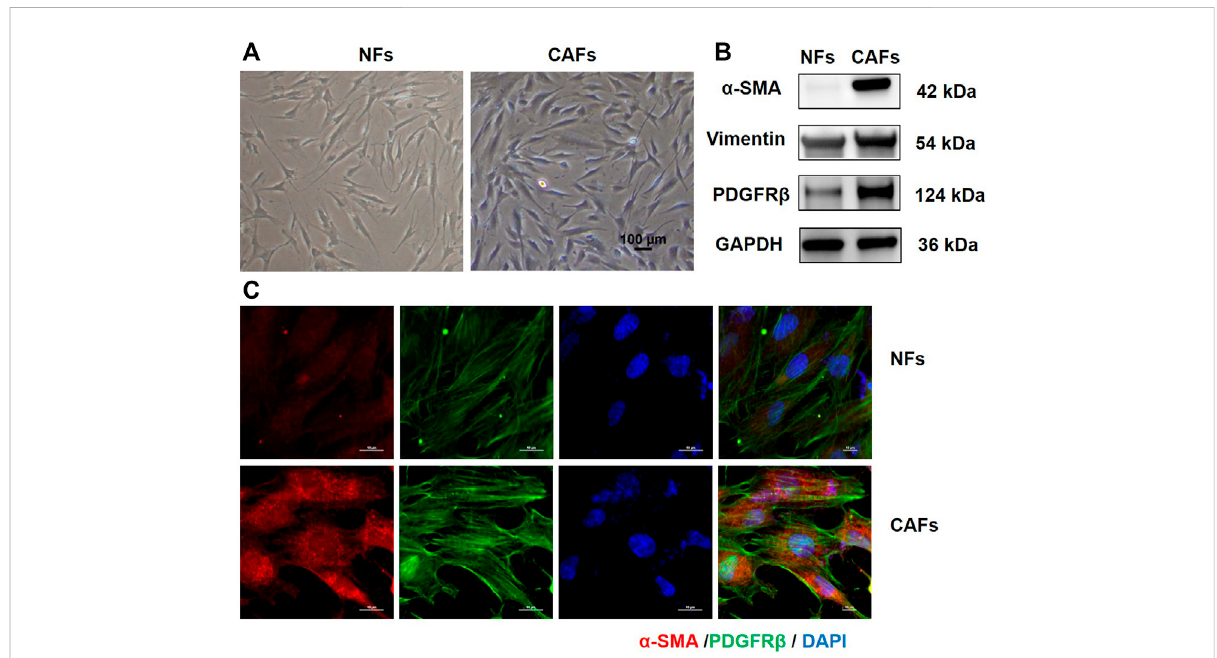
FIGURE 1 Cultureandidenti fi cationofprimarytumor-associated fi broblasts. (A) MorphologyofNFsandCAFsunderinvertmicroscope(100×). (B) Protein levelsof α -SMA,VimentinandPDGFR β inNFsandCAFsdetectedbyWesternblottinganalysis. (C) Expression levelsof α -SMAandPDGFR β inNFsand CAFs were observed by immuno fl